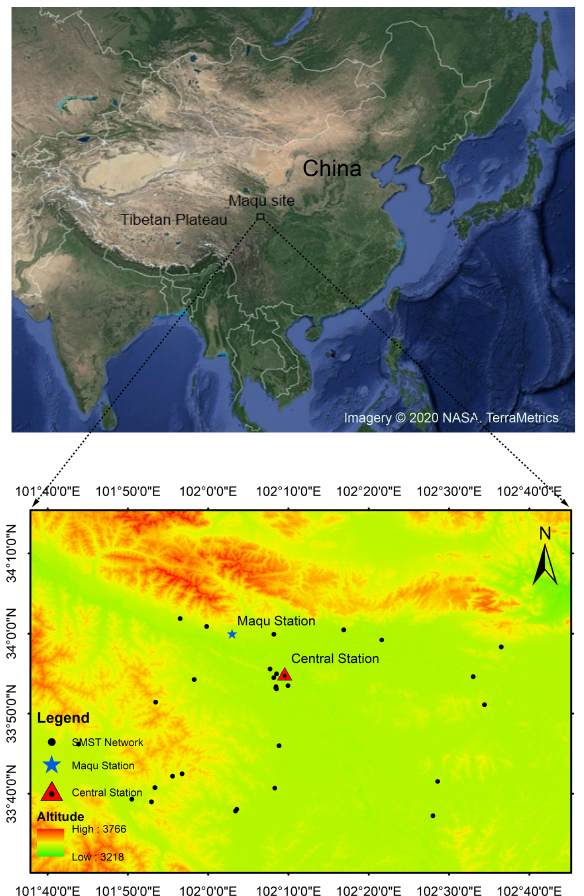
Figure 1. Geographical location of Maqu soil moisture and temper- ature (SMST) monitoring network and the center station. ©